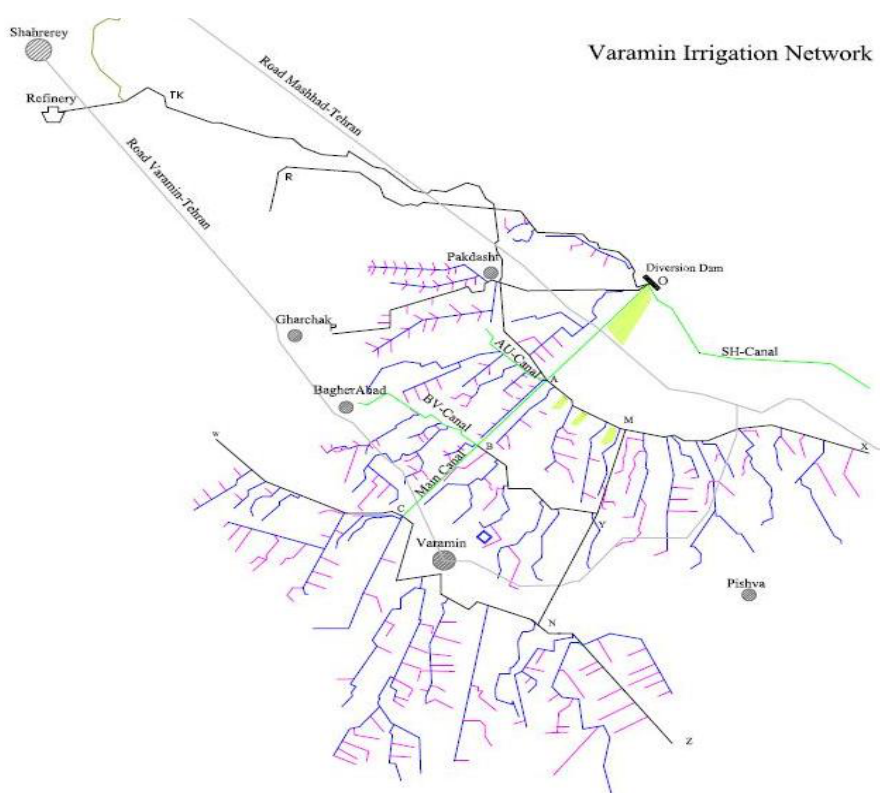
Fig. 1 A view of Varamin Irrigation